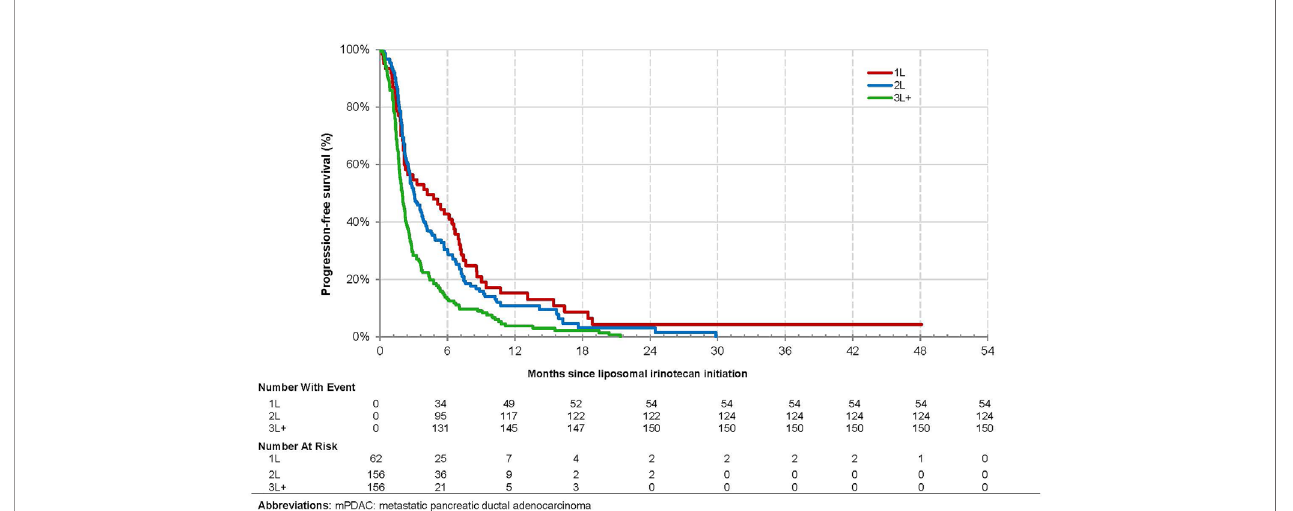
FIGURE 4 | Kaplan-Meier Analysis of Progression Free Survival among Patients with mPDAC Treated with Liposomal Irinotecan in a Doublet with